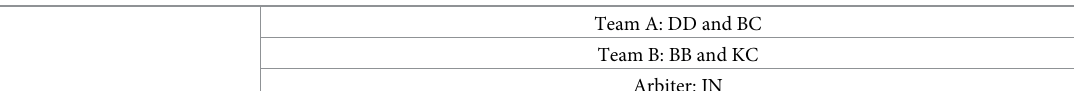
Table 3. Search strategy.